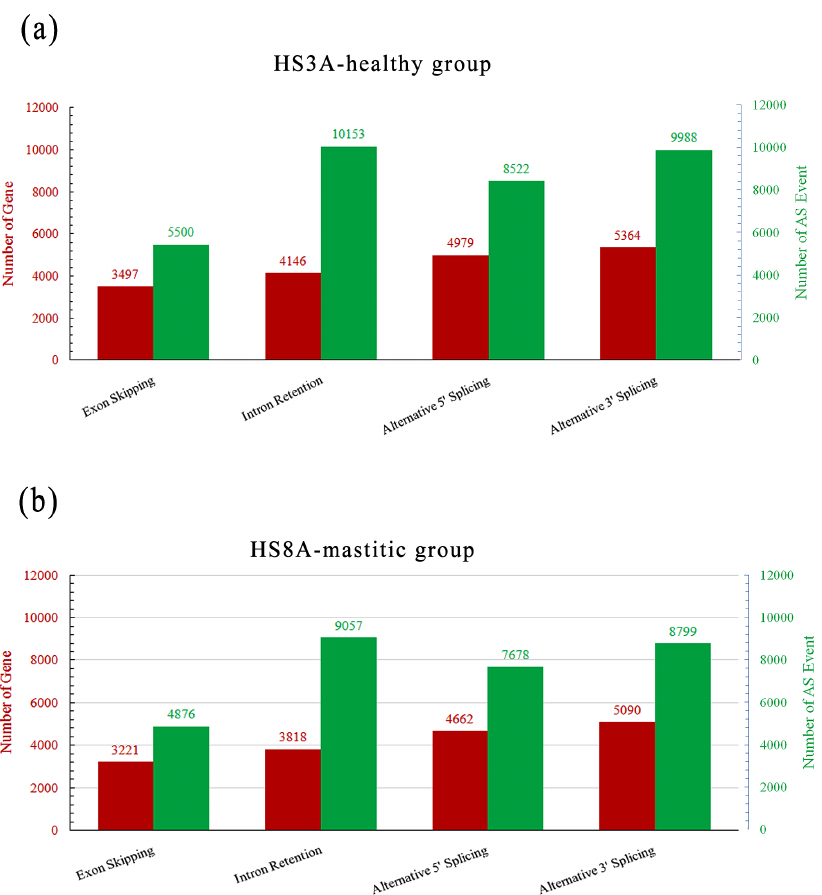
Fig 2. Novel transcripts harboring QTLs associated with clinical mastitis in the two groups. BTA: Bovine autosome.